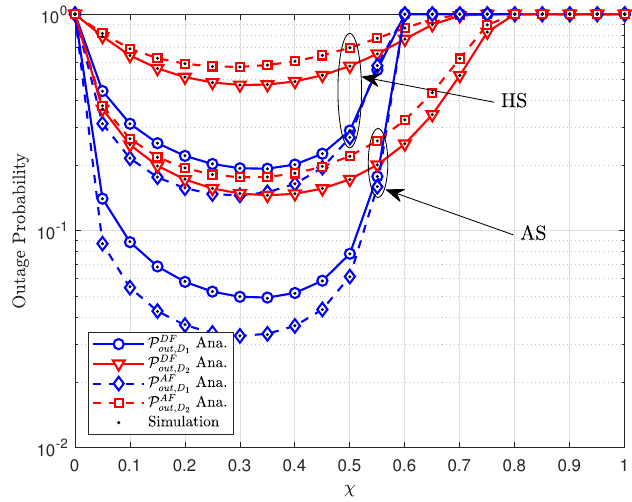
Figure 6. The outage probability versus transmit χ .